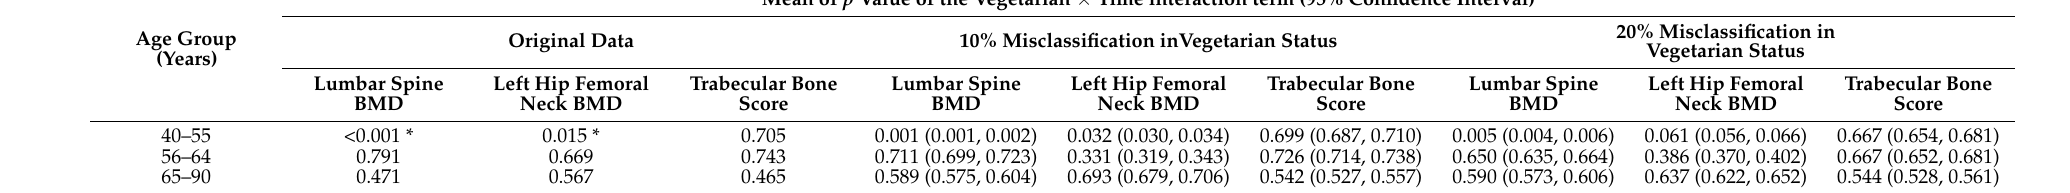
Table 5. Simulation-based sensitivity analysis of 10% and 20% misclassification in the vegetarian status on the change in lumbar spine BMD, left hip femoral neck BMD, and trabecular bone score over